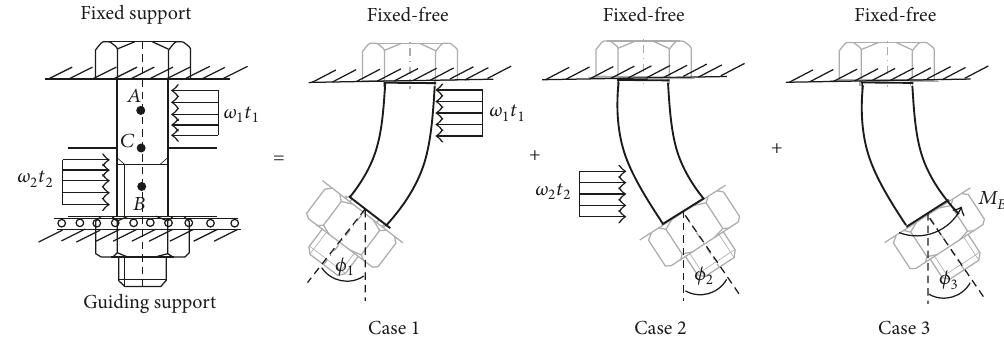
Figure 12: Rotation of the